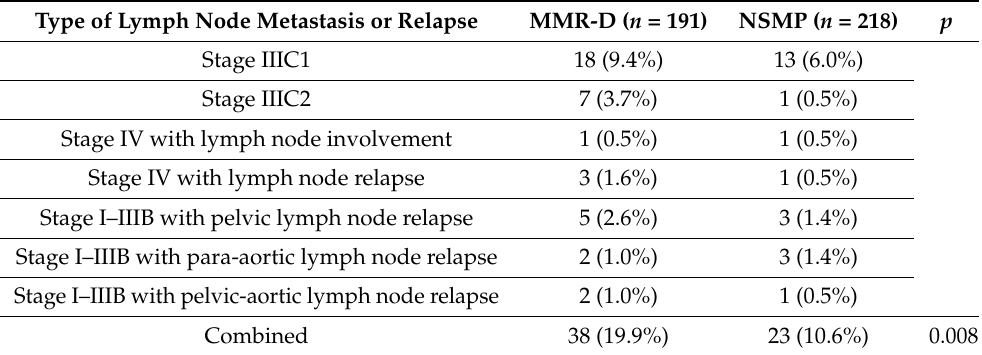
Table 6. Occurrence of primary lymph node involvement and recurrences in regional lymph nodes in MMR-D and NSMP endometrial carcinomas.